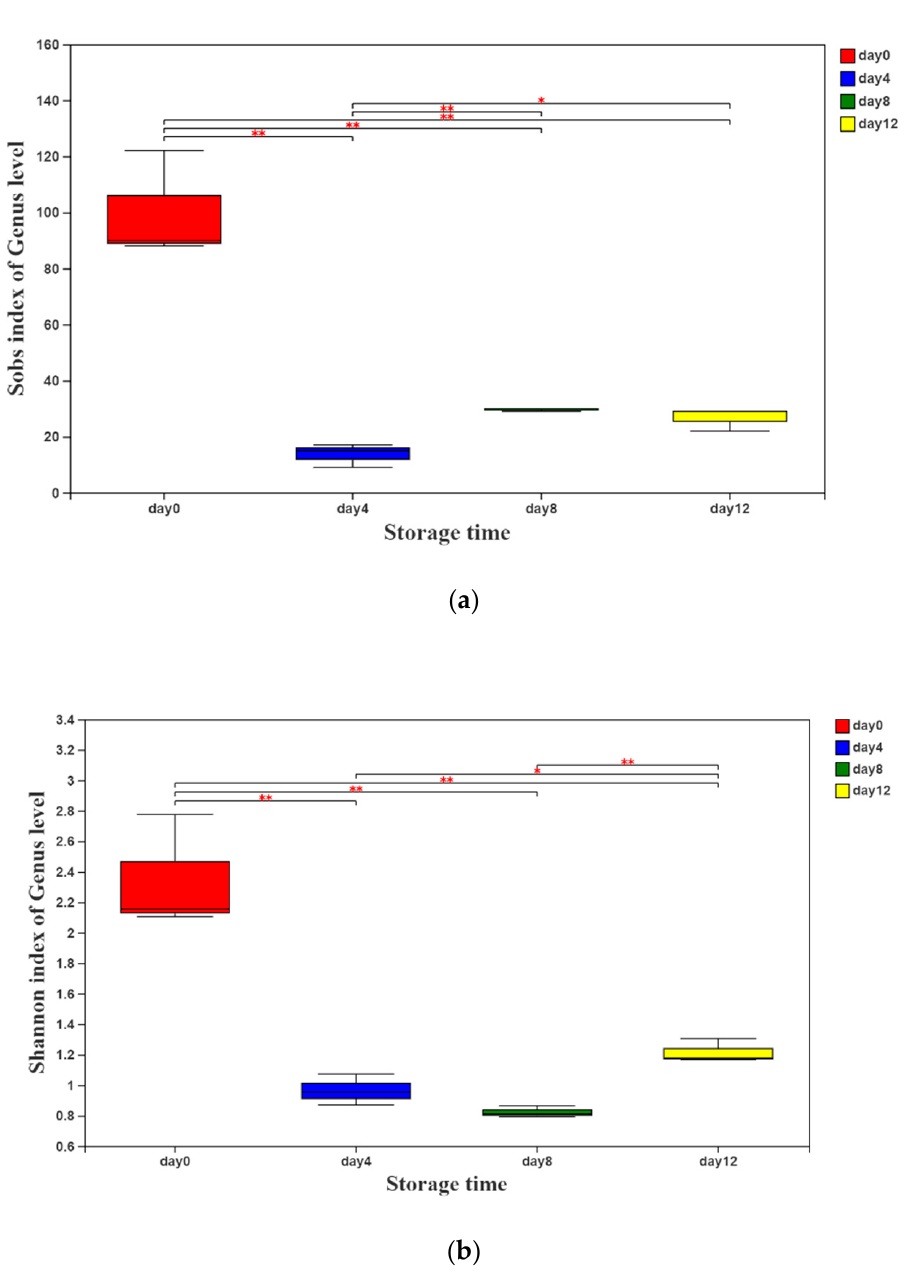
Figure 1. Sobs ( a ) and Shannon ( b ) indices of the genus level of vacuum-packaged peeled potatoes during storage. The significant difference between the storage days, p ≤ 0.05, is marked as *, and p ≤ 0.01 is marked as **.